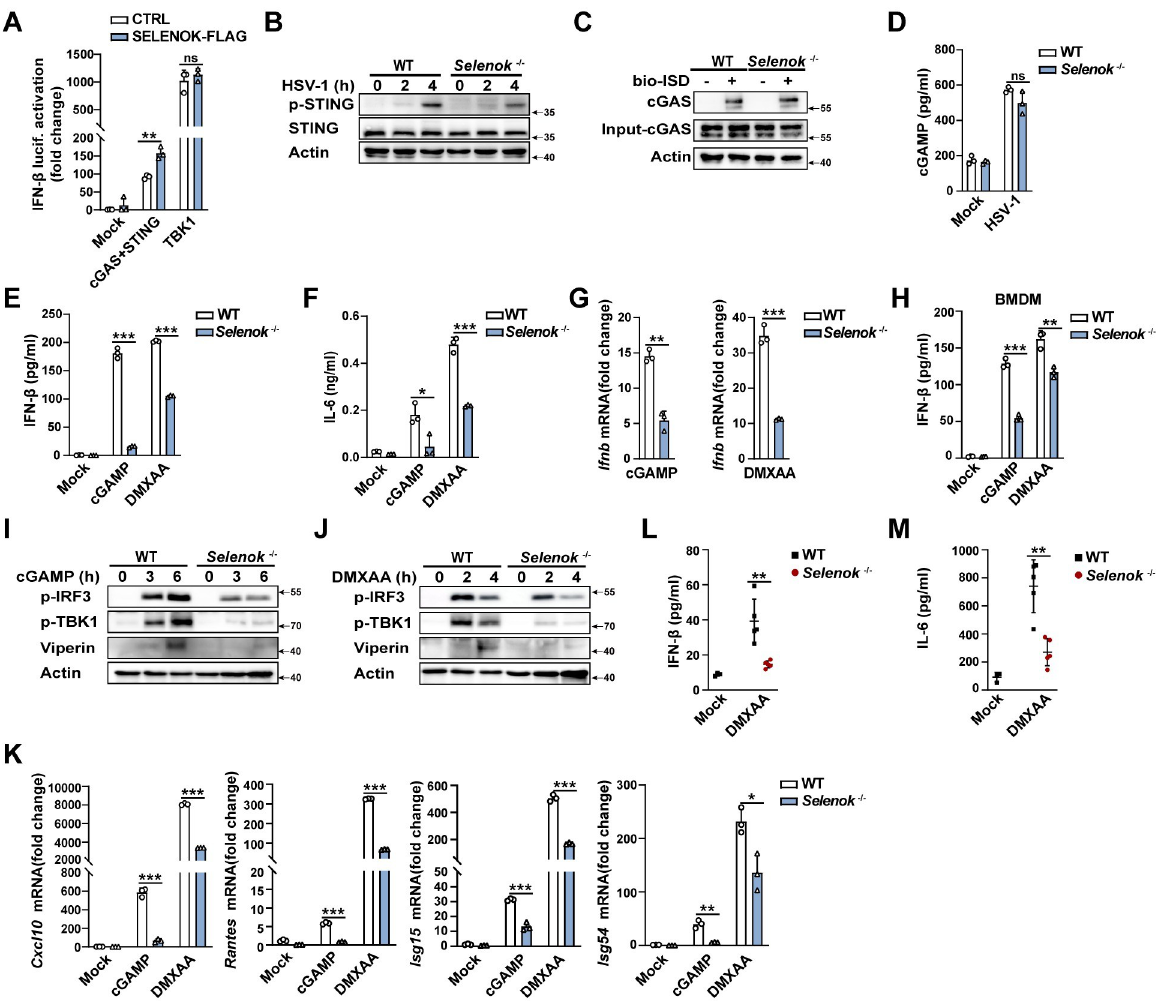
Fig 4. Selenok deficiency inhibits STING activation. (A) Luciferase activity assays of IFN- β activation in HEK 293T cells transfected with control vector or SELENOK, followed by transfection with control vector (Mock), cGAS plus STING, and TBK1. (B) Immunoblot analysis of phosphorylated and total STING in PMs stimulated with HSV-1. (C) In vitro pull-down of cGAS and ISD. (D) ELISA analysis of cGAMP secretion in PMs stimulated with HSV-1. (E) ELISA analysis of IFN- β secretion in PMs following stimulation with cGAMP and DMXAA. (F) ELISA analysis of IL-6 secretion in PMs following stimulation with cGAMP and DMXAA. (G) Real-time PCR analysis of Ifnb mRNA levels in PMs stimulated by cGAMP and DMXAA. (H) ELISA analysis of IFN- β secretion in BMDMs following stimulation with cGAMP and DMXAA. (I and J) Immunoblot analysis of p-IRF3, p-TBK1, and Viperin expression with (I) cGAMP stimulation or (J) DMXAA stimulation. (K) Real-time PCR analysis of Cxcl10 , Rantes , Isg15 , and Isg54 mRNA levels in PMs following stimulation with cGAMP and DMXAA. (L–M) Mice were stimulated by DMXAA for 6 h by i.p. injection. (L) Serum levels of IFN- β were analyzed using ELISA (mock, n = 3; DMXAA, n = 5). (M) Serum levels of IL-6 were analyzed using ELISA (mock, n = 3; DMXAA, n = 5). Statistical significance was determined by unpaired two-sided multiple Student’s t-tests in A, D-H, and K-M. Data represent mean ± standard deviation (SD) or one representative image from three independent experiments. ns: not significant. * : P < 0.05, ** P: < 0.01, *** P: < 0.001.